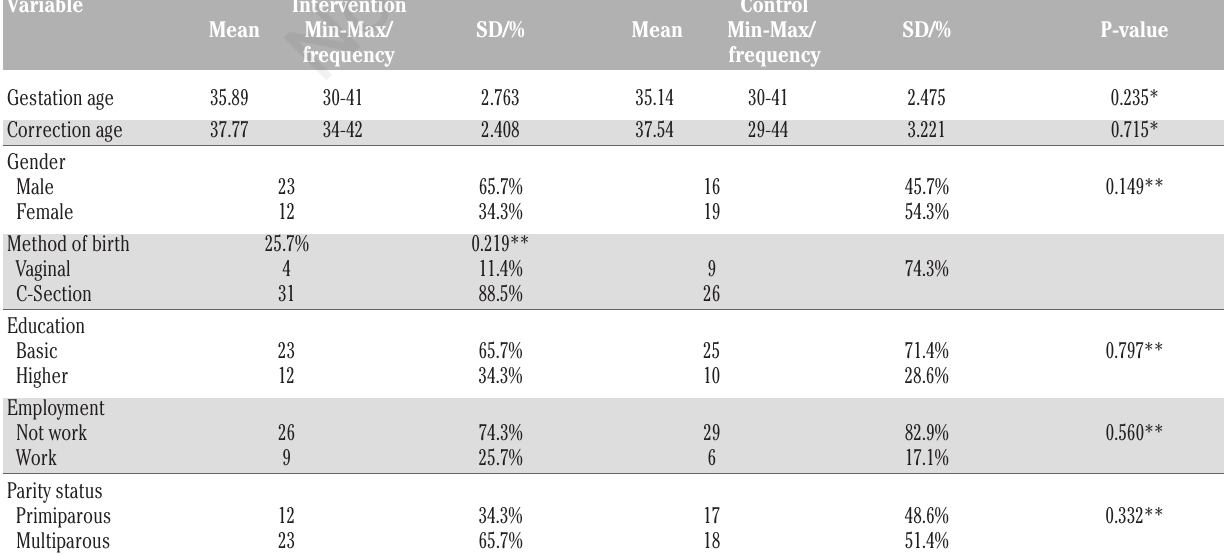
Table 1. Distribution of respondents based on gestation age, correction age, gender, method of birth, education, employment, and par- ity status of mother.